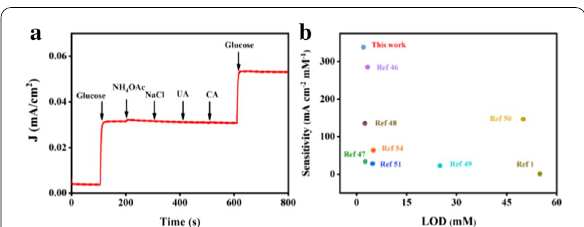
Fig. 6 a The response currents of Cu NP@PC after injection of 0.01 mM glucose solution, 0.01 mM ammonium acetate (NH 4 OAc), 0.01 mM sodium chloride (NaCl), 0.01 mM urea (UA), 0.01 mM citric acid (CA), respectively; and b The compassion of LOD and sensitivity between Cu NP@PC and previously reported